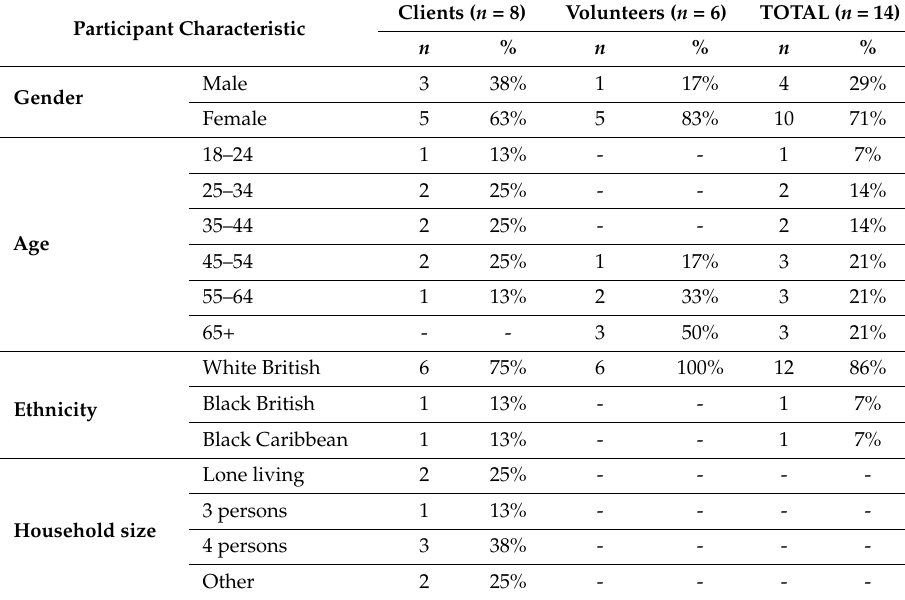
Table 1. Demographic characteristics of